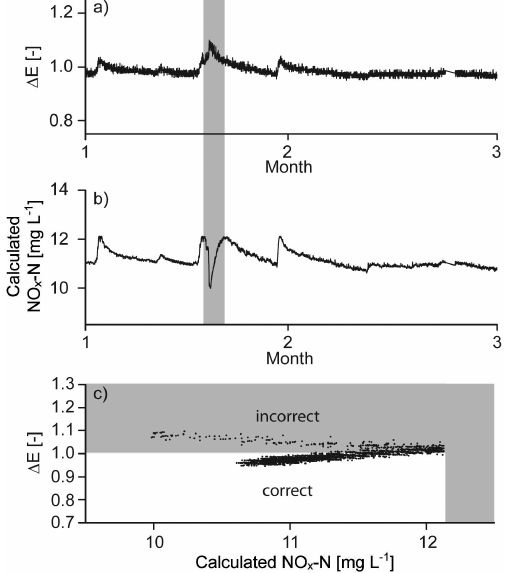
Figure 4. Example of discrepancies between wavelength and calcu- lated NO x -N concentrations as displayed by the DWS. The shaded grey area highlights the data set of incorrect NO x -N calculated values. (a) Raw data set of recorded wavelength values during 2 months. (cid:49) E is the difference between light extinction at 218 and 228nm. (b) Calculated NO x -N concentrations from the raw data set as reported by the DWS. (c) Values of the raw data set ( (cid:49)E ) and the reported NO x -N concentrations of the DWS. Once NO x -N values reached 12.12mgL − 1 , values were incorrectly calculated in an opposite trend.